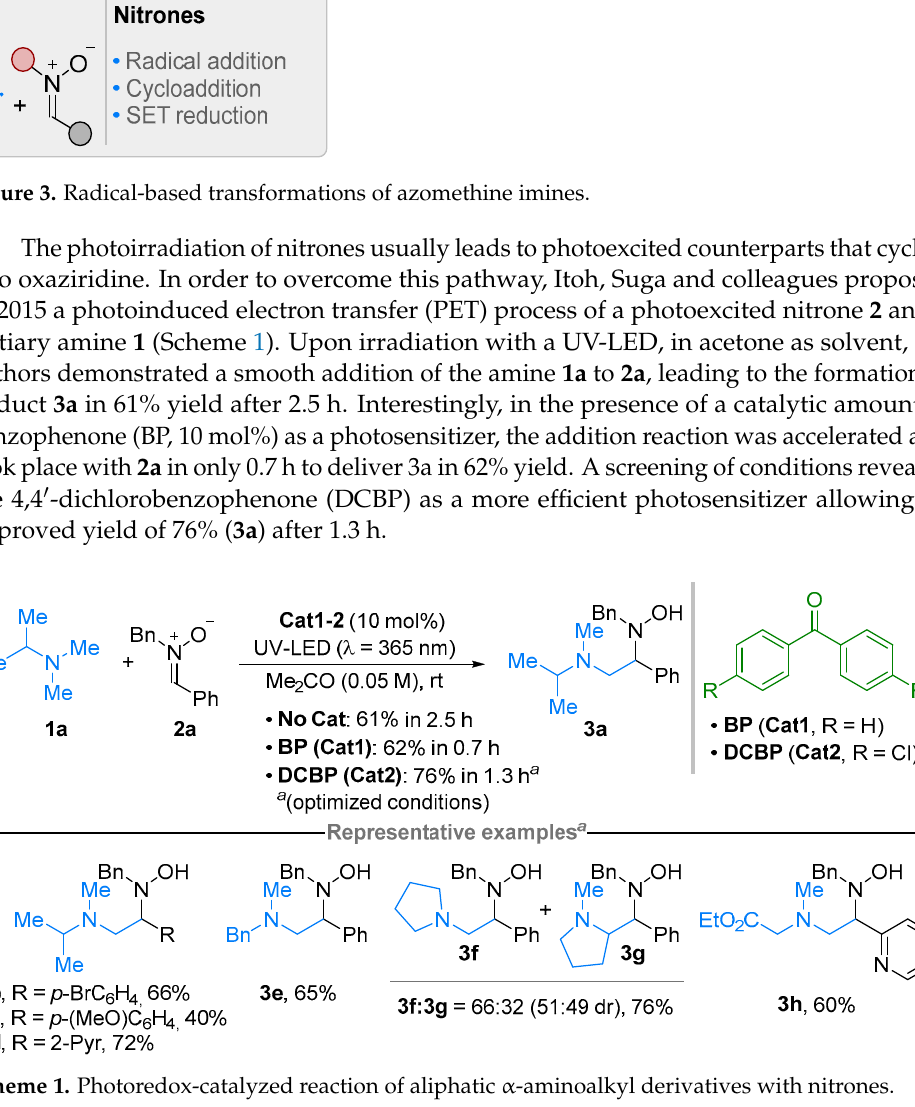
Figure 2. Scope of this review.